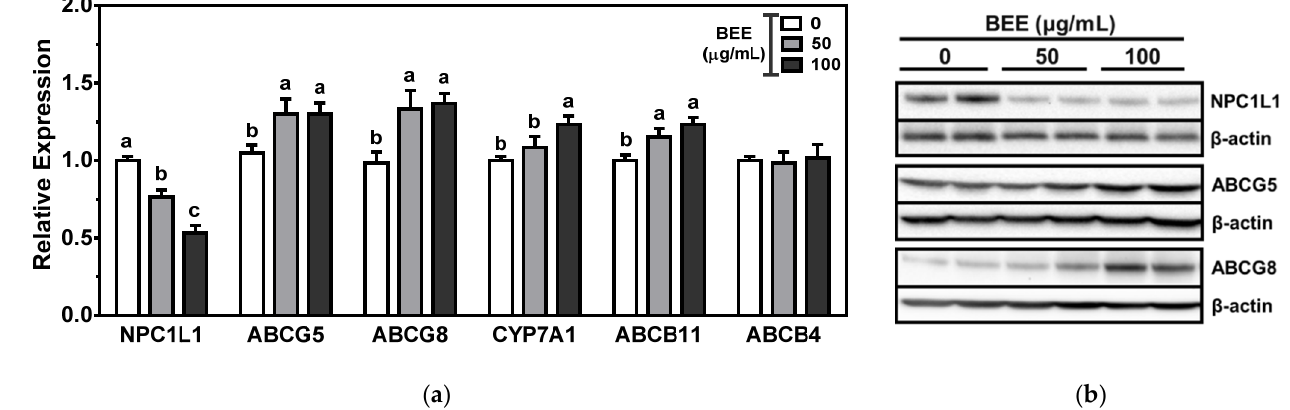
Figure 3. The effect of BEE on the genes for cholesterol flux in HepG2 cells. The cells were treated with 50 or 100 µ g/mL of BEE for 24 h. ( a ) The hepatic gene expression was measured by qRT-PCR analysis. Data are expressed as relative expressions to control. Different letters indicate significant differences ( p < 0.05). Values are means ± S.E.M. n = 6. ( b ) The representative image of the Western blot from two different experiments is shown. β -actin was used as a loading control.